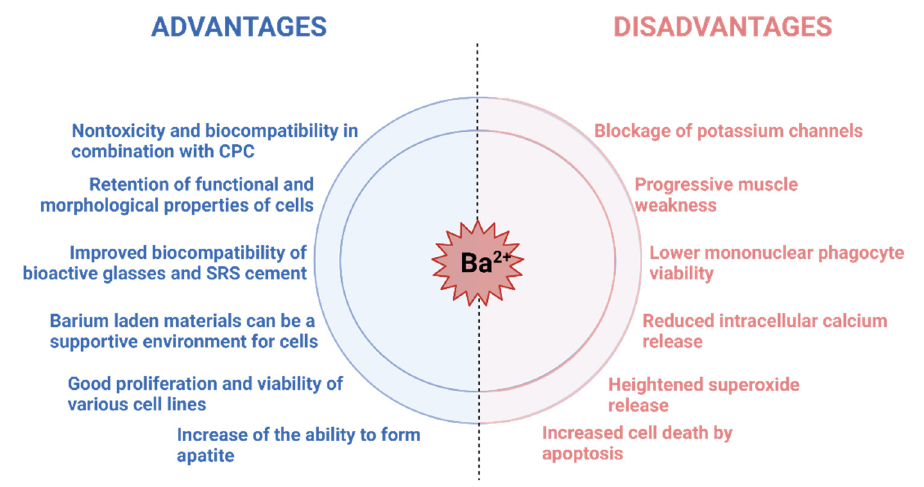
Figure 6. Brief overview of effects recorded in the presence of barium ions in vitro and in vivo . Figure created with BioRender.com .